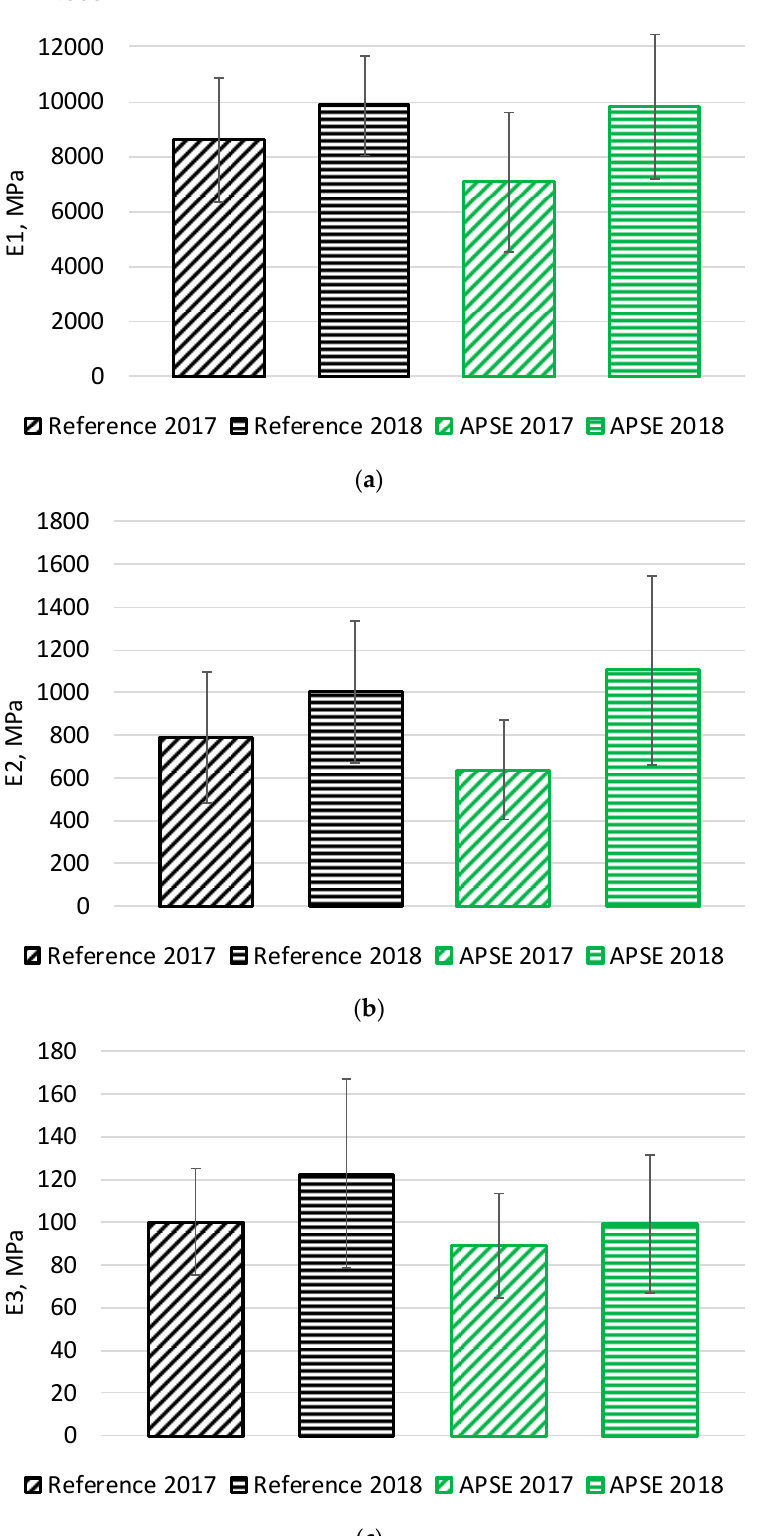
Figure 6. Elastic modulus of pavement structure layers at the years 2017 and 2018: ( a ) E1—Asphalt layers, ( b ) E2—Sub-base, ( c ) E3—Sub-grade.